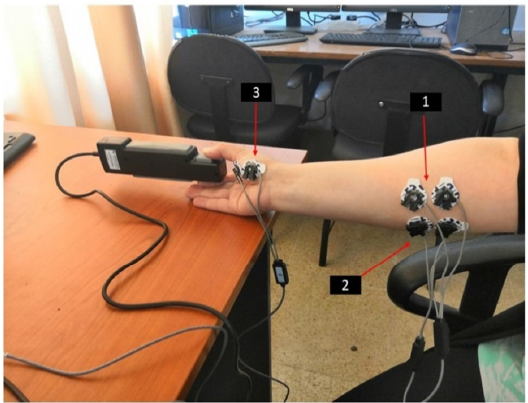
Fig. 1.Surface electrode locations on each muscle. 1. Flexor Carpi Radialis (FCR), 2. Flexor Digitorum Superficialis (FDS), and 3. Abductor Pollicis Brevis (ABP).